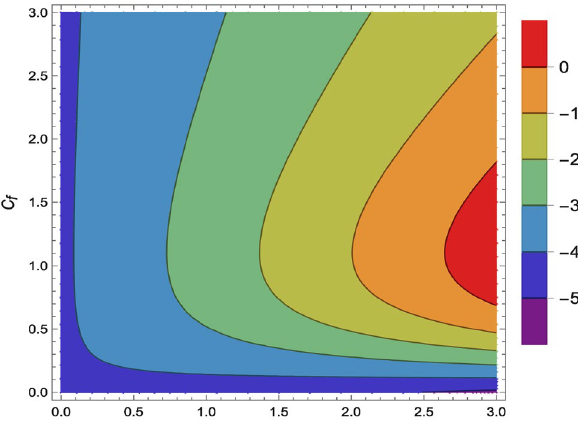
Figure 27. C f due to n .